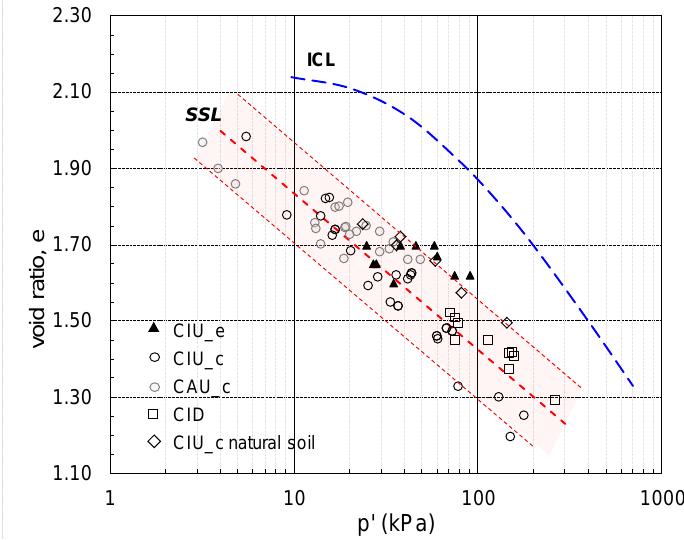
Figure 9. Steady state conditions of the specimens of Cervinara ash in the compression plane.